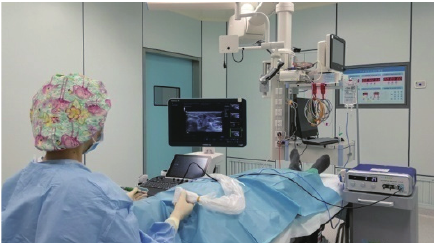
Figure 5 Patient position and puncture operator position: Foot-side orientation.